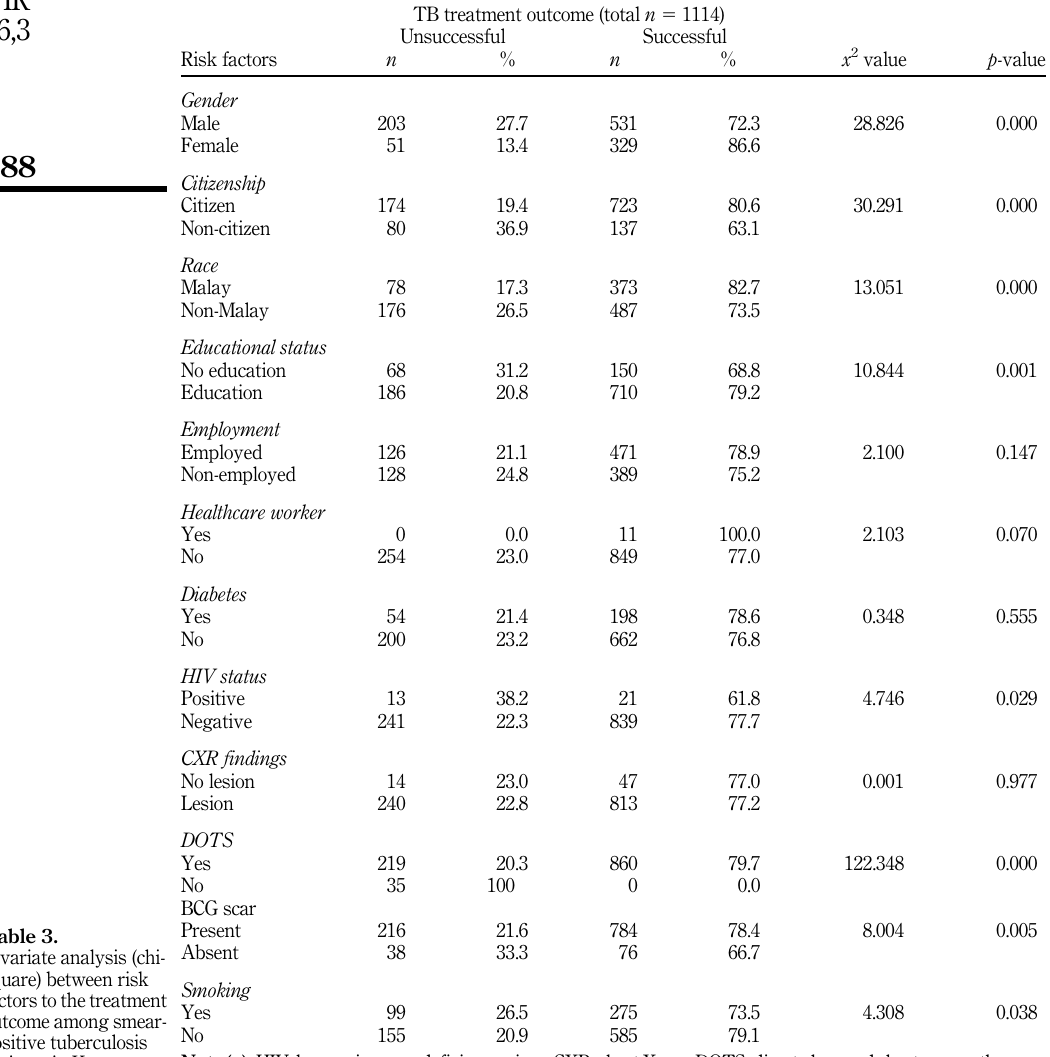
Table 3. Bivariate analysis (chi- square) between risk factors to the treatment outcome among smear- positive tuberculosis patients in Kepong